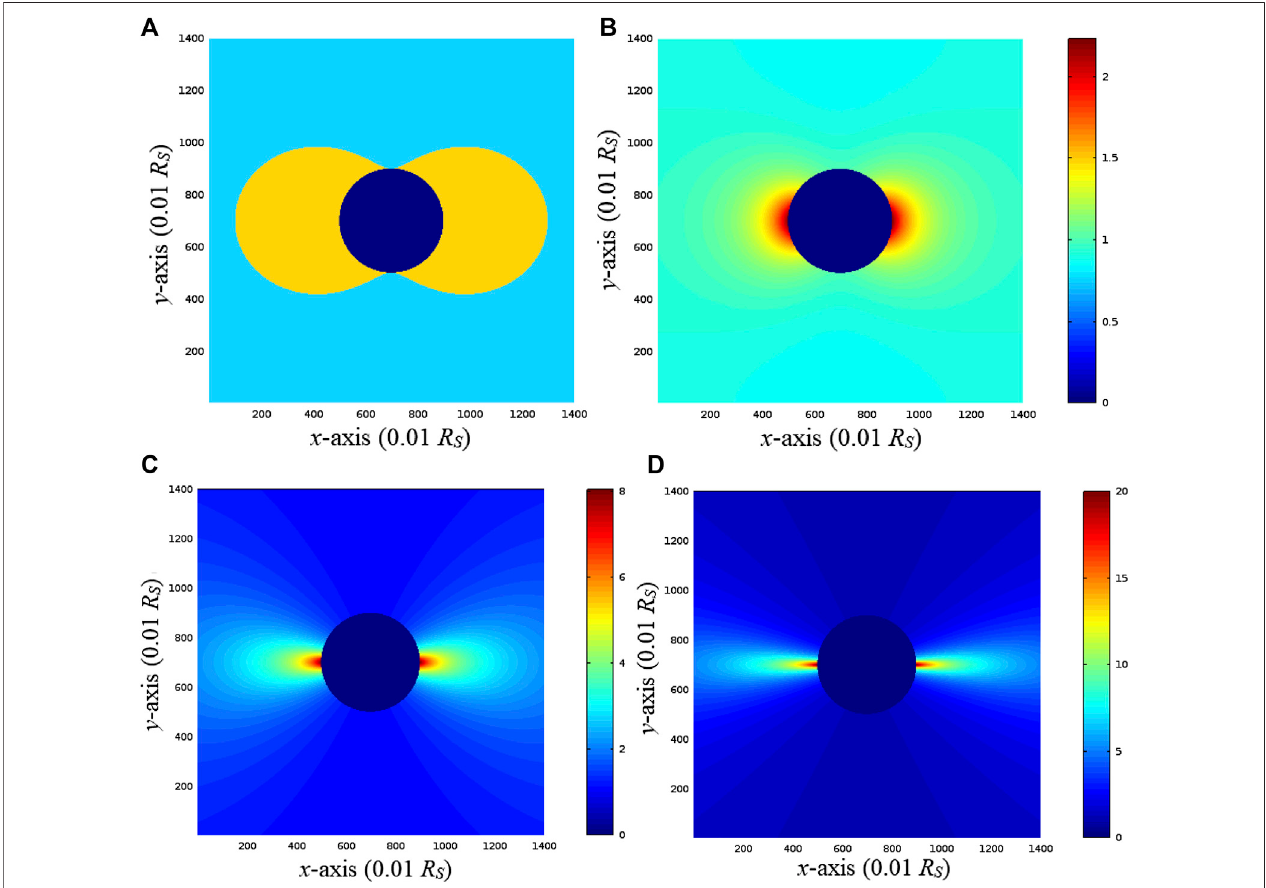
FIGURE3|(A) Superluminalregionisdenotedbyyellow.Thecenterofthepictureisasphericalregionwitharadiusof R S (deepbluecolor).Inthiscase, a (cid:1) 2 R S and R Q (cid:1) 0.999 R S .The maximum distancefor thesuperluminal phenomenon from thecenter oftheblack hole is3 R S at θ (cid:1) π /2. (B) Speed distribution oflightat a (cid:1) 2 R S and R Q (cid:1) 0.999 R S . (C) Speed distribution oflightat a (cid:1) 8 R S and R Q (cid:1) 0.999 R S .Themaximumdistanceofthesuperluminalphenomenonis33 R S fromthecenteroftheblack hole in this case. (D) Speed distribution at a (cid:1) 20 R S and R Q (cid:1) 0.999 R S . The maximum distance of the superluminal phenomenon is 201 R S from the center of the black hole in this case. In all these cases, the rotational axes are parallel to the y-axis, and the color bars show in units of c.